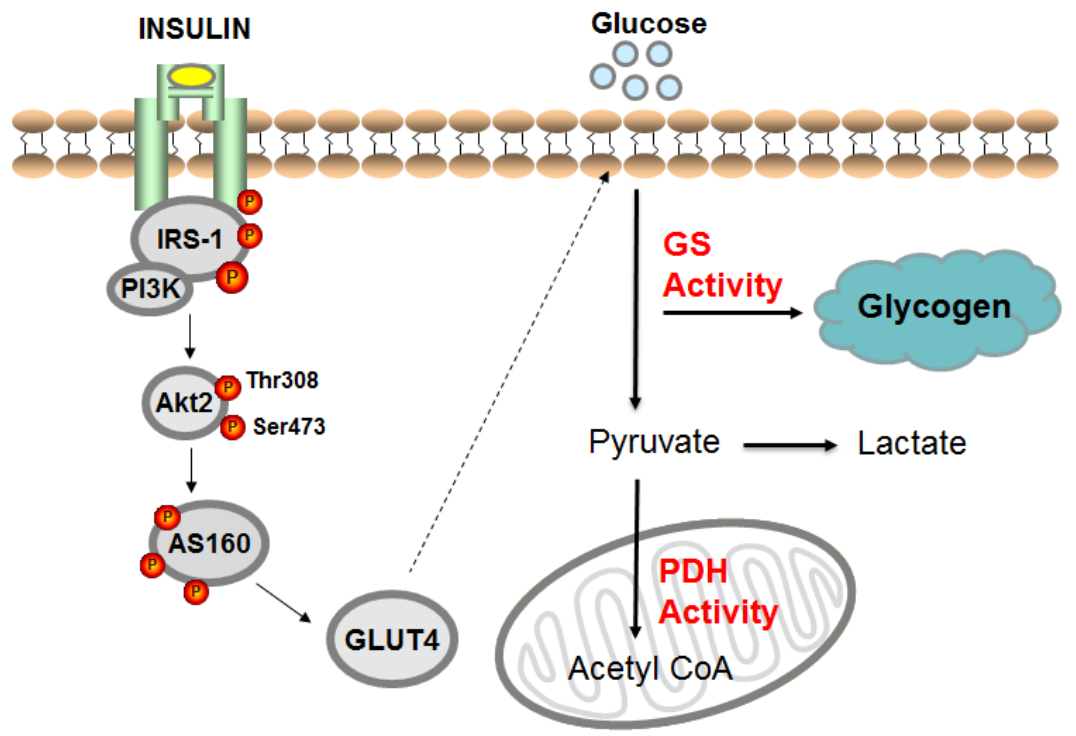
Figure 1. Overview of insulin-stimulated skeletal muscle glucose metabolism in humans. Once insulin binds to the insulin receptor, it activates a signaling cascade resulting in glucose transporter type 4 (GLUT4) translocation to the plasma membrane which facilitates glucose uptake into the muscle cell. The majority of glucose that enters the cell is either stored as glycogen, oxidized in the mitochondria, or converted to lactate. IRS-1: insulin receptor substrate 1; PI3K: phosphoinositide 3-kinase; GS: glycogen synthase; PDH: pyruvate dehydrogenase.